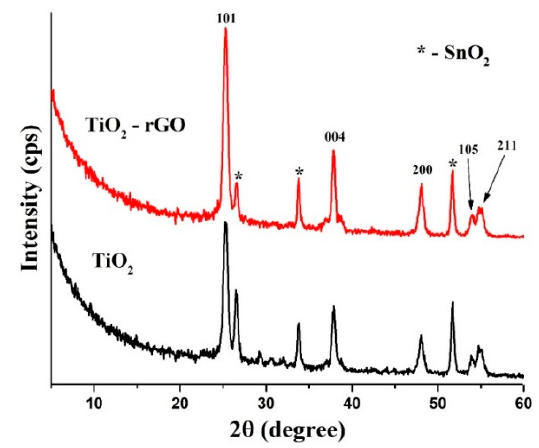
Figure 3. XRD patterns of TiO 2 and TiO 2 –rGO films.